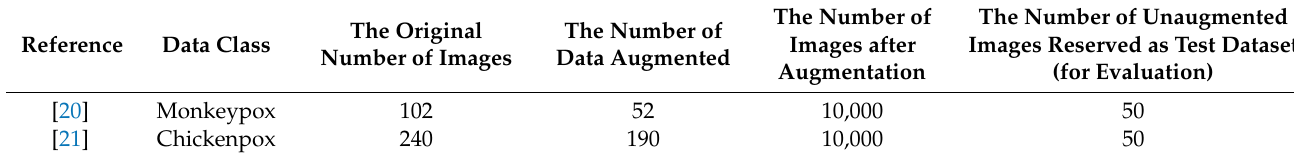
Table 1. The distribution of the